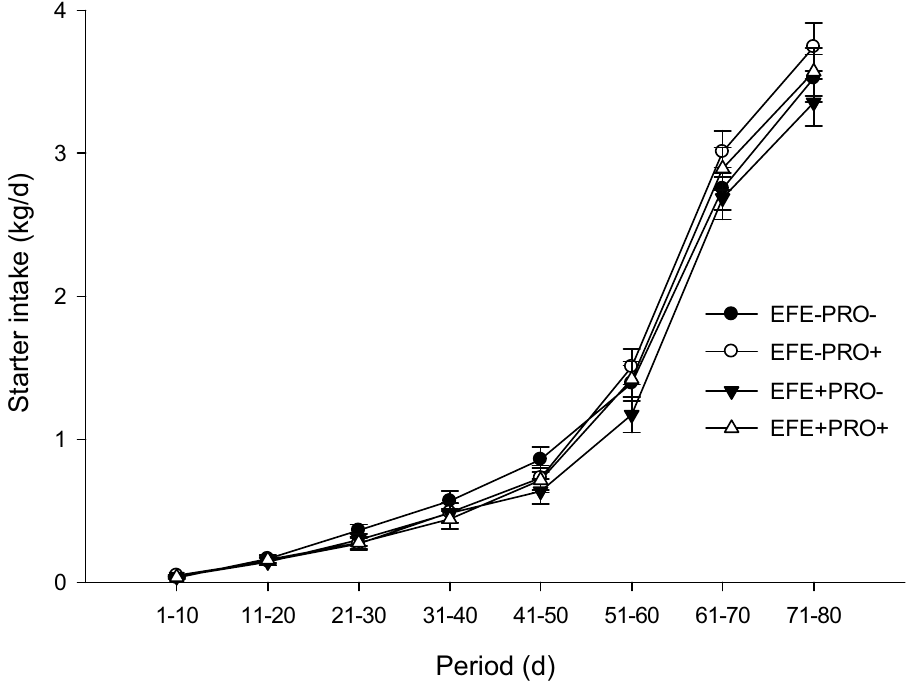
Figure 2. Starter feed intake in calves receiving different experimental diets. Treatments were (1) calves fed diets without exogenous fibrolytic enzymes (EFE)-treated wheat straw and probiotic supplement